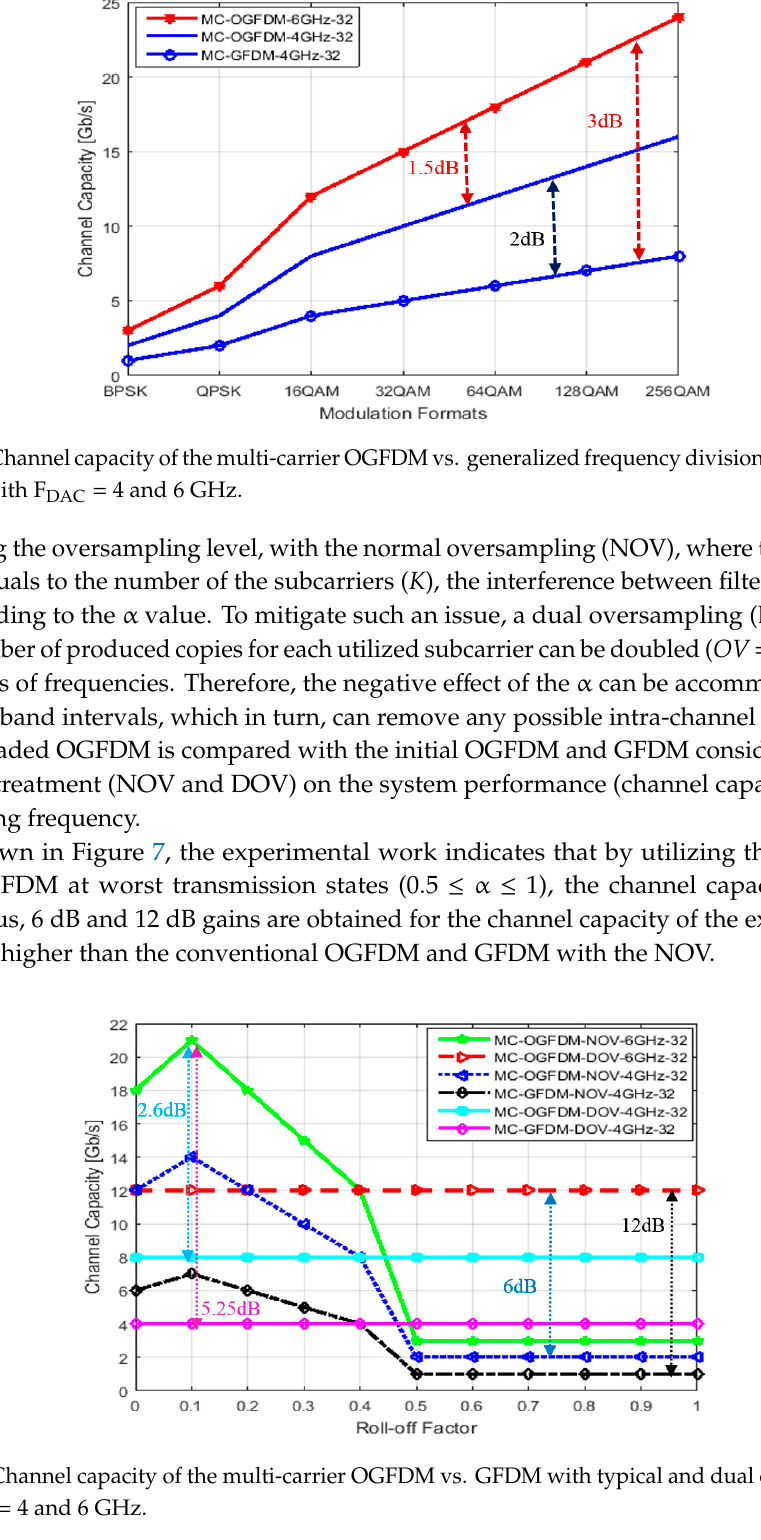
Figure 8. Three significant adaptive areas, low boost (LB), medium boost (MB), and high boost (HB) between two sequential fixed modulation schemes (128 and 256 QAM). The first case (LB) is calculated for a 25%-bit-rate improvement with the SNR threshold equals to 24.1 dB where different possible arrangements of the bit loading map can be shown for this ratio